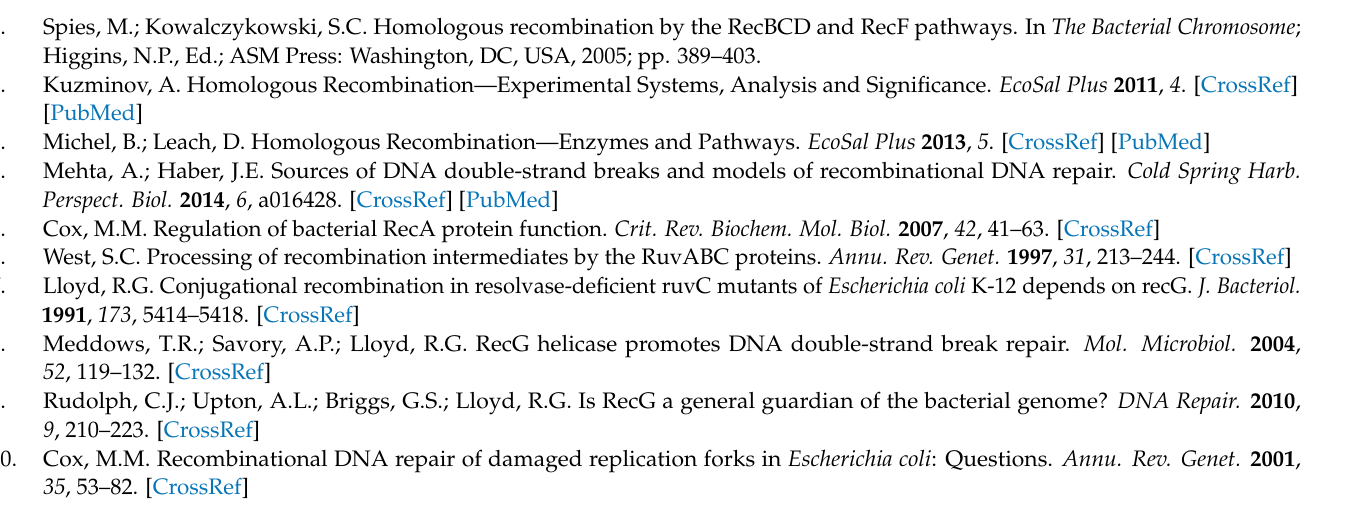
work. Figure S1. Growth of different TRM387 derivatives. Figure S2. Effects of γ - and UV-irradiation on growth rates of different recombination mutants of E. coli . Figure S3. Formation of anucleate cells in ruvABC mutants after introduction of double-strand DNA breaks by I-SceI endonuclease. Table S2. E. coli strains divided into groups (Tukey HSD test, alpha = 0.05) based on the data on survival at 60 min after I- Sce I expression (Table 1). Table S3. Statistical analysis of differences in survival at 60 min after I- Sce I expression (Table 1) presented as pairwise p -values ( p adj) from the Tukey HSD test, which controls for multiple testing. Table S4. Statistical analysis of differences in the occurrence of filamentous, anucleate and regular cells in different strains after 60 min of I- Sce I expression (Table 2). Table S5. E. coli strains divided into groups (Tukey HSD test, alpha = 0.05) based on the data analysed on γ -survival at 200 Gy (see also Figure 4). Table S6. Statistical analysis of differences in survival after 200 Gy of γ -irradiation (see also Figure 4) presented as pairwise p -values ( p adj) from the Tukey HSD test, which controls for multiple testing. Table S7. Statistical analysis of differences in the occurrence of filamentous, anucleate and regular cells in different strains after UV dose of 5 J/m 2 (Table 3). Table S8. Statistical analysis of differences in the occurrence of filamentous, anucleate and regular cells in different strains after γ -dose of 100 Gy (Table 3). Table S9. E. coli strains divided into groups (Tukey HSD test, alpha = 0.05) based on the data on UV-survival at 50 J/m 2 (see also Figure 9). Table S10. Statistical analysis of differences in survival after 50 J/m 2 of UV (see also Figure 9) presented as pairwise p -values ( p adj) from the Tukey HSD test, which controls for multiple